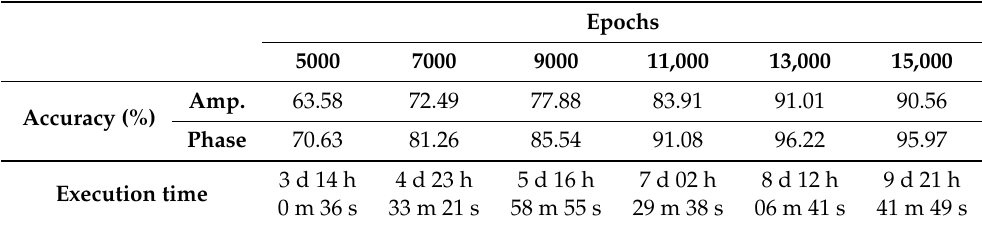
Table 8. Training results for excited signal prediction regression network using sampling line data (6000 test data, pre-trained network: Alexnet).